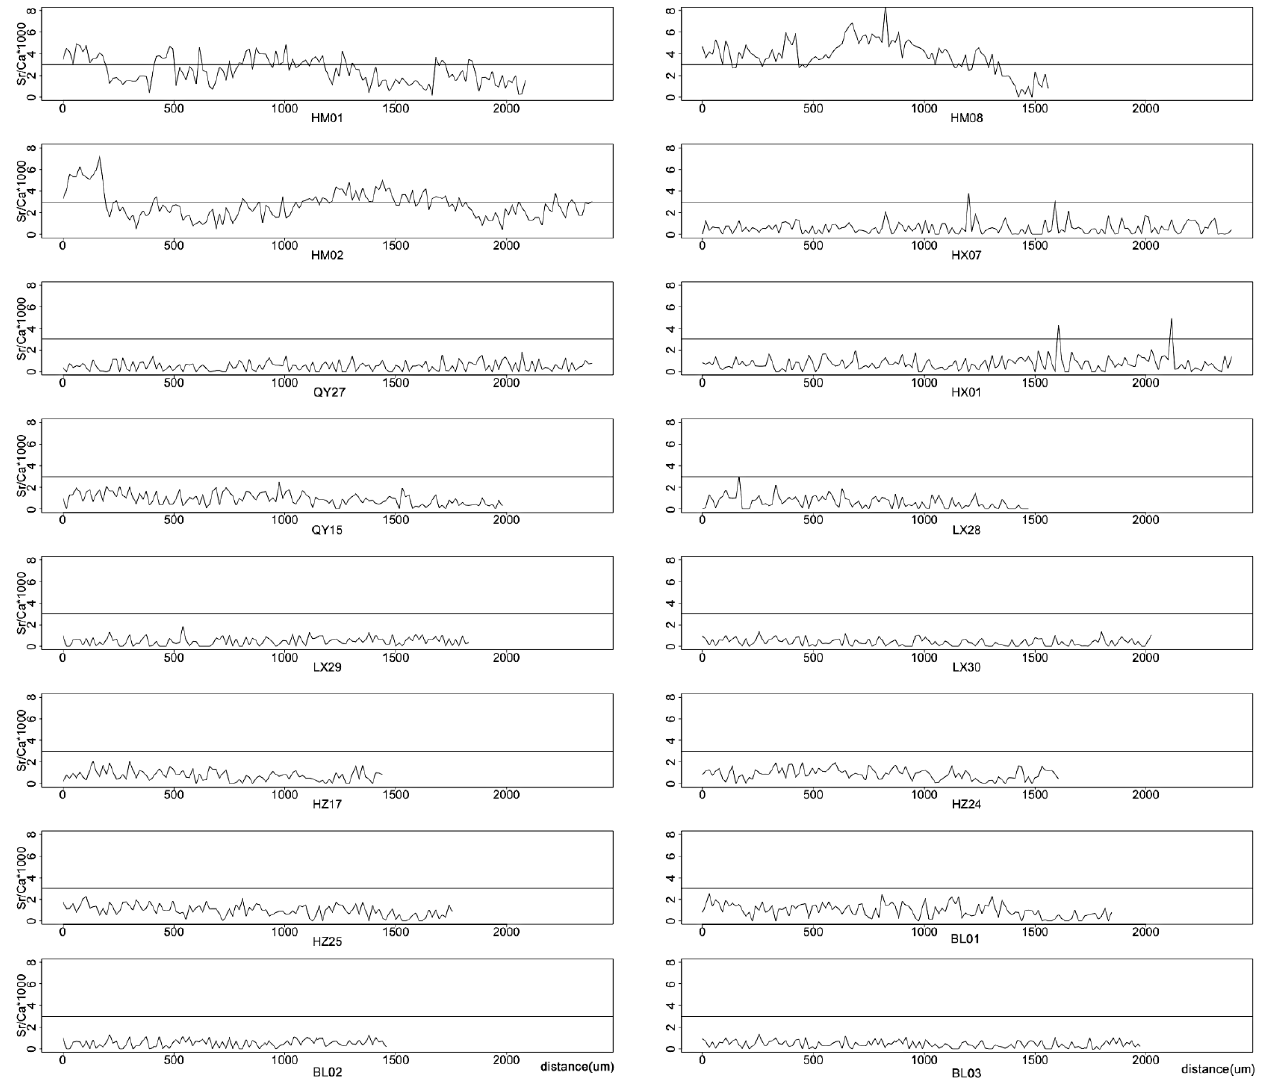
Figure 3. Changes in Sr: Ca ratios from core to the edge of sagittal otolith of Coilia grayii collected from HM, HX, QY, LX, HZ, BL. The Sr: Ca ratios lowering than 3 were considered to be indicative of a freshwater phase and the Sr: Ca ratios ranging from 3 to 5 were considered to be indicative of a brackish water experience.